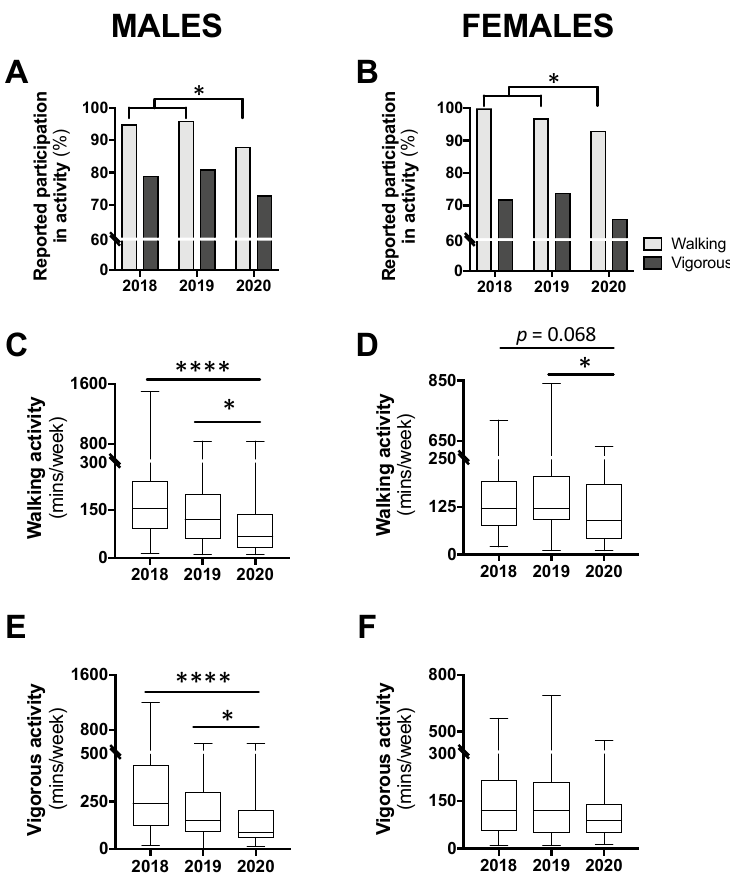
Figure 4. Levels of participation in physical activity ( A , B ) and time spent in walking ( C , D ) or vigorous activity ( E , F ) in class year 2020 ( n = 66 males, 83 females) compared with 2018 ( n = 61 males, 97 females) and 2019 ( n = 73 males, 104 females). Data are presented as the proportion of students included in this analysis each year ( A , B ), or median ± IQR and range ( C – F ). For ( A , B ), no statistical differences were observed between 2018 and 2019 and, therefore, to meet the assumptions of the chi-square test, these years were combined and compared with 2020; * p < 0.05 between 2020 and 2018 / 2019 by chi-square test. For ( C – E ), * p < 0.05 between 2020 and 2019 and **** p < 0.0001 between 2020 and 2018 by Kruskal–Wallis test.